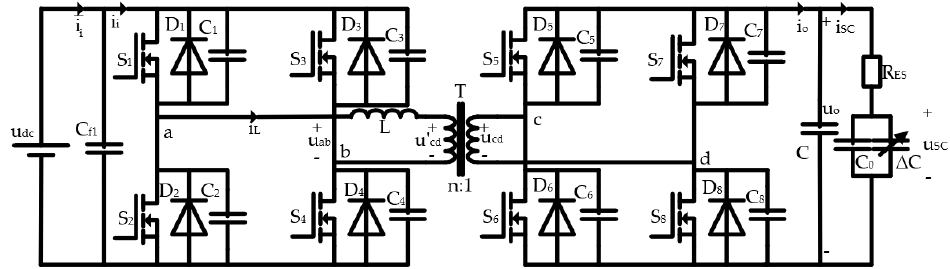
Figure 2. Topology of the DAB-SC system.